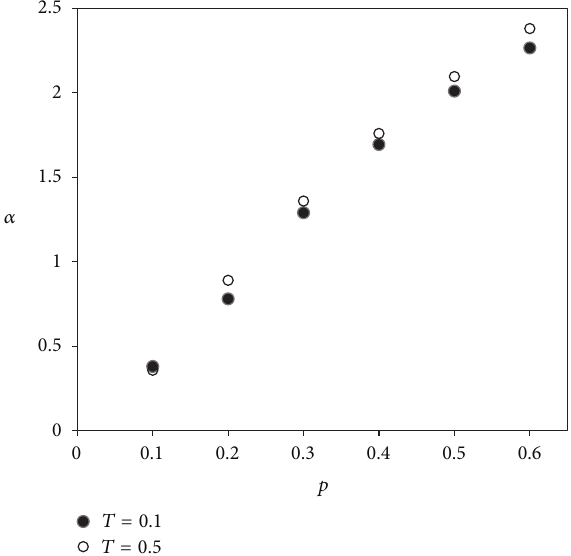
Figure 11: Behavior of 𝛼 on varying 𝑝 . Homogeneous history . The structures exhibit QLRO. 𝑊 = 1 , 𝑁 = 60 .